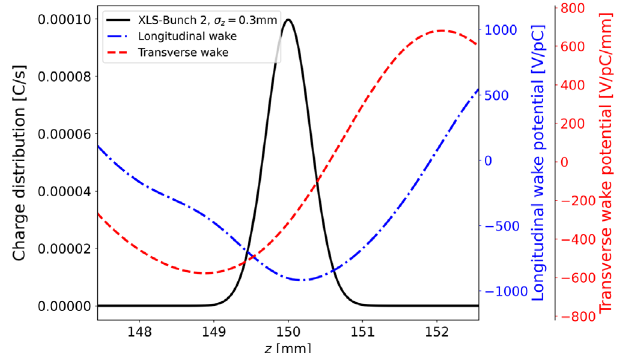
FIG. 19. Magnitude of the longitudinal (dash-dotted blue line) and transverse (dashed red line) long-range wakefields on a 30- cm TWS, as seen by a second bunch.